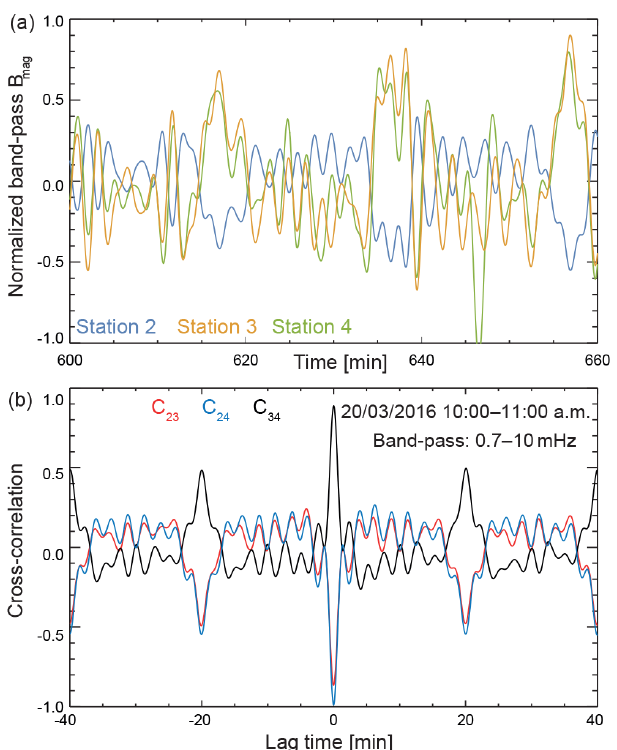
Figure 7. (a) Band-passed 0.7–10mHz time series for all three sta- tions on 20 March 2016 between 10:00 and 11:00PDT. (b) The cor- relation coefficients between pairs of stations as a function of lag. Stations 3 and 4 are highly correlated (in phase), while station 2 is respectively anticorrelated (out of phase).